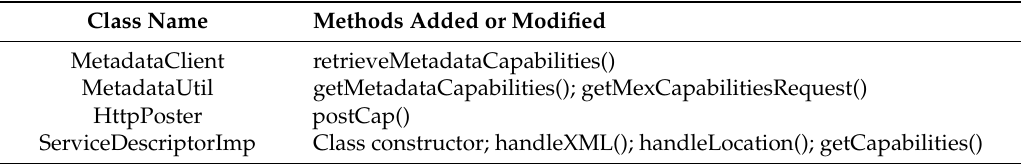
Table 2. Java classes of the client package affected by the